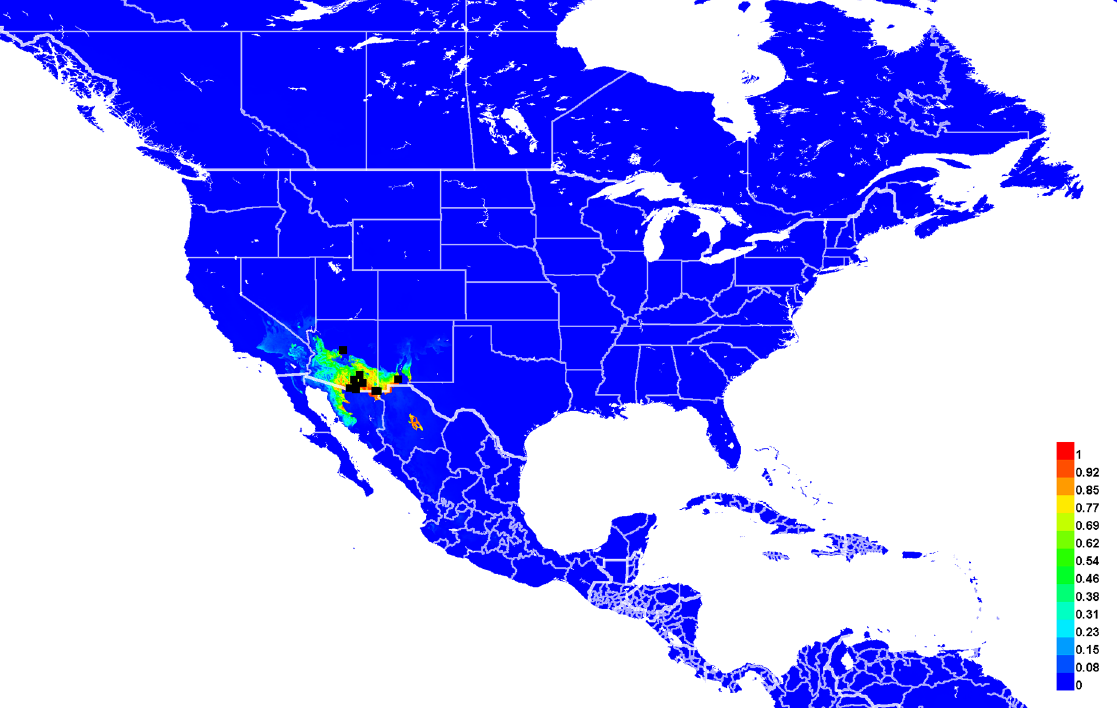
Fig. 66. Georeferenced collection records of Lasioglossum ( D. ) minckleyi sp. nov. (black squares) and predicted distribution by maximum entropy ecological niche modeling in Maxent (colour shading). Warmer colours indicate higher cloglog probability of